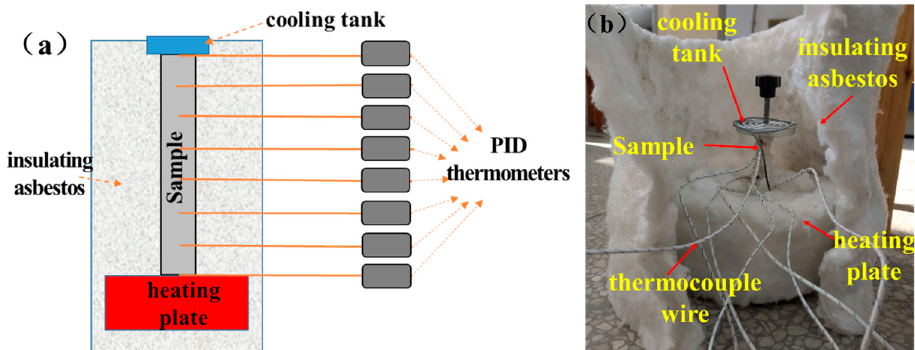
Figure 1. ( a ) Diagram of the gradient heat treatment experiment; ( b ) photo of the heat treatment experiment.